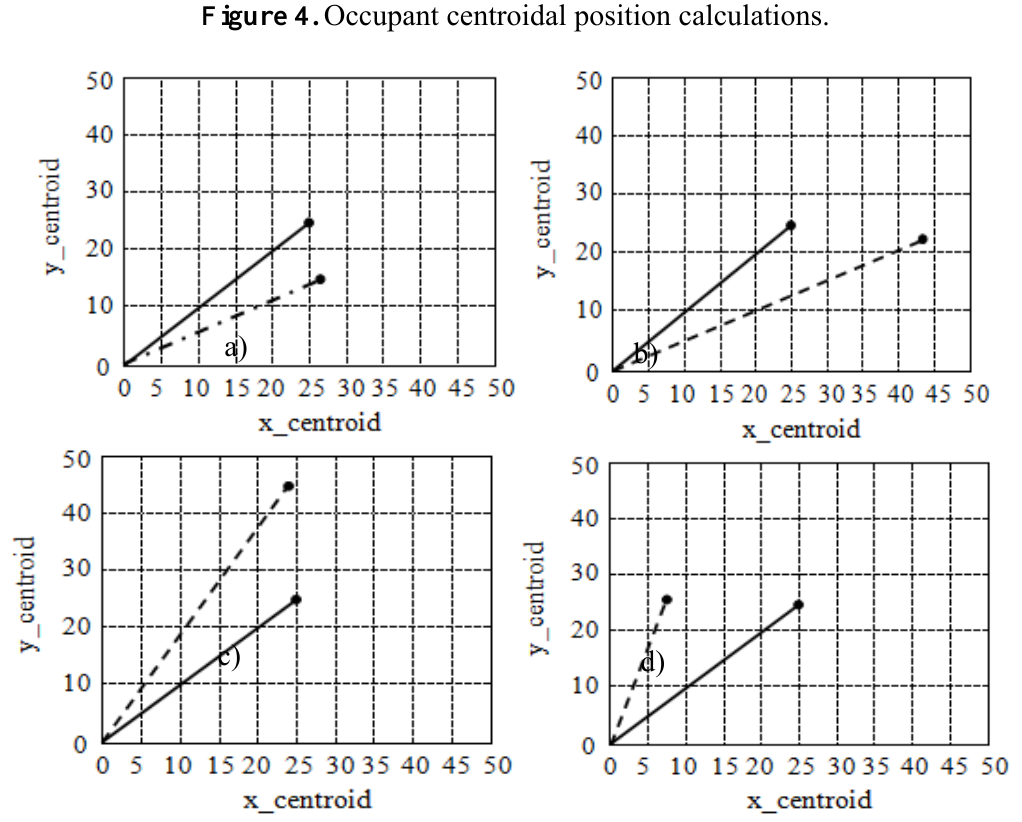
Figure 4. Occupant centroidal position